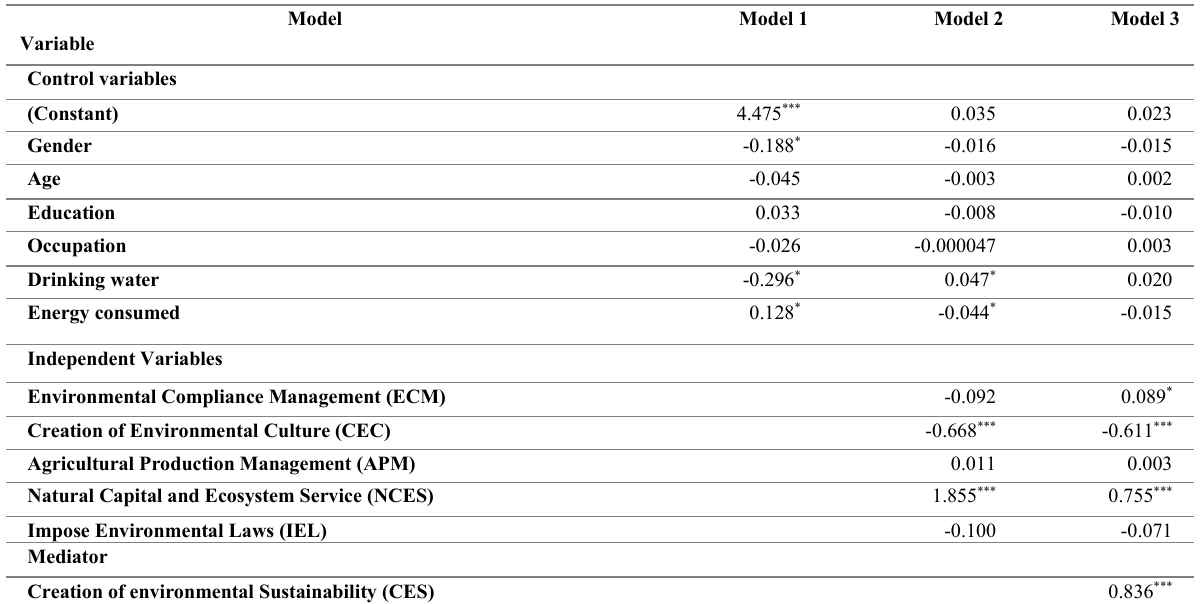
Table 4: Multiple Linear Regression Analysis of